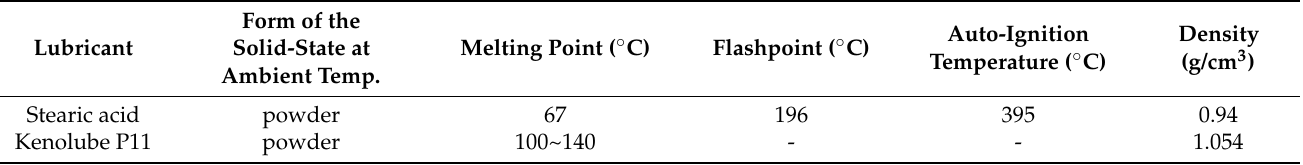
Table 2. Characteristics of the lubricants used in the study. Form of the Lubricant Solid-State at Ambient Temp.